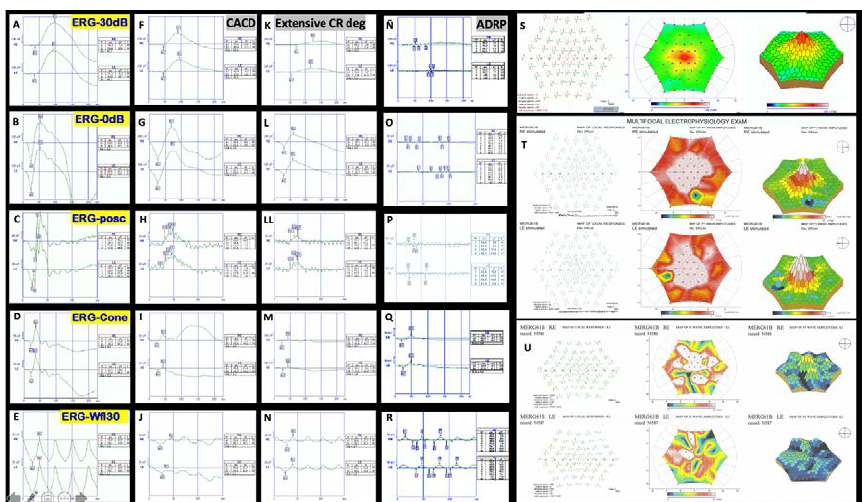
Figure 7. Examples of ERGs . On the left-hand side is a normal ffERG from F8-II-2 ( A,B,C,D,E ), and